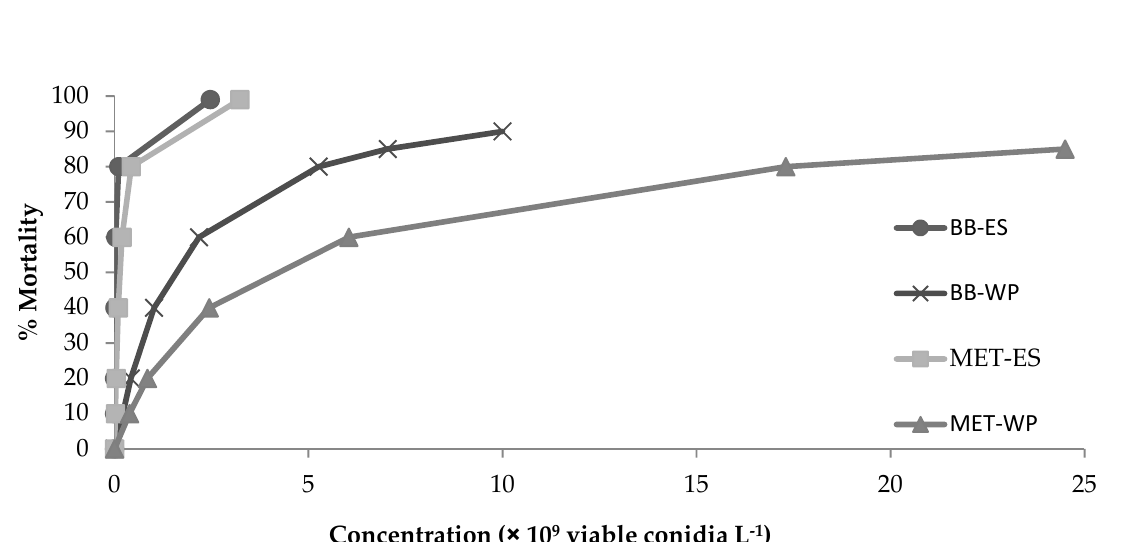
Figure 1. Estimated percentage mortality of Tuta absoluta pupae subjected to different concentrations of four entomopathogenic fungal formulations.